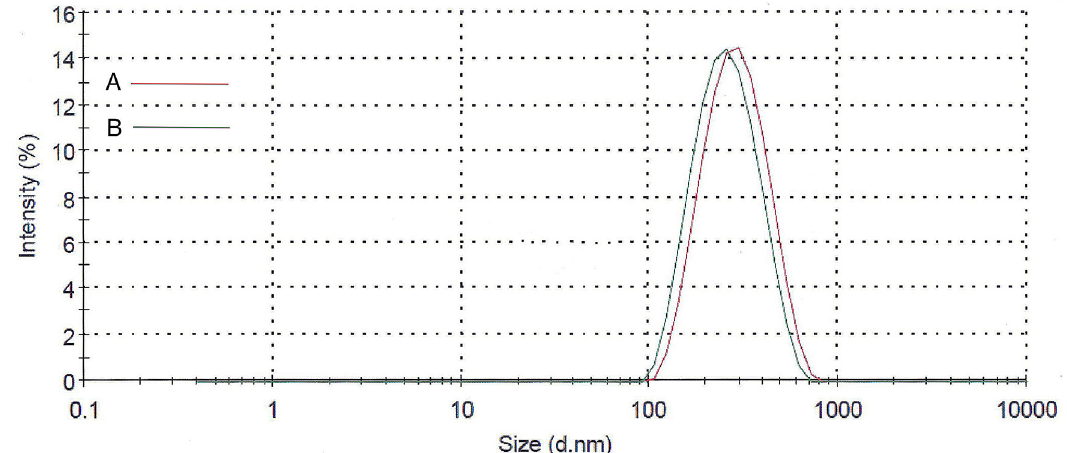
FIGURE 1 - Particle diameters of placebo and M-PEGNC.(A) M-PEGNC; (B) Placebo(B-PEGNC).